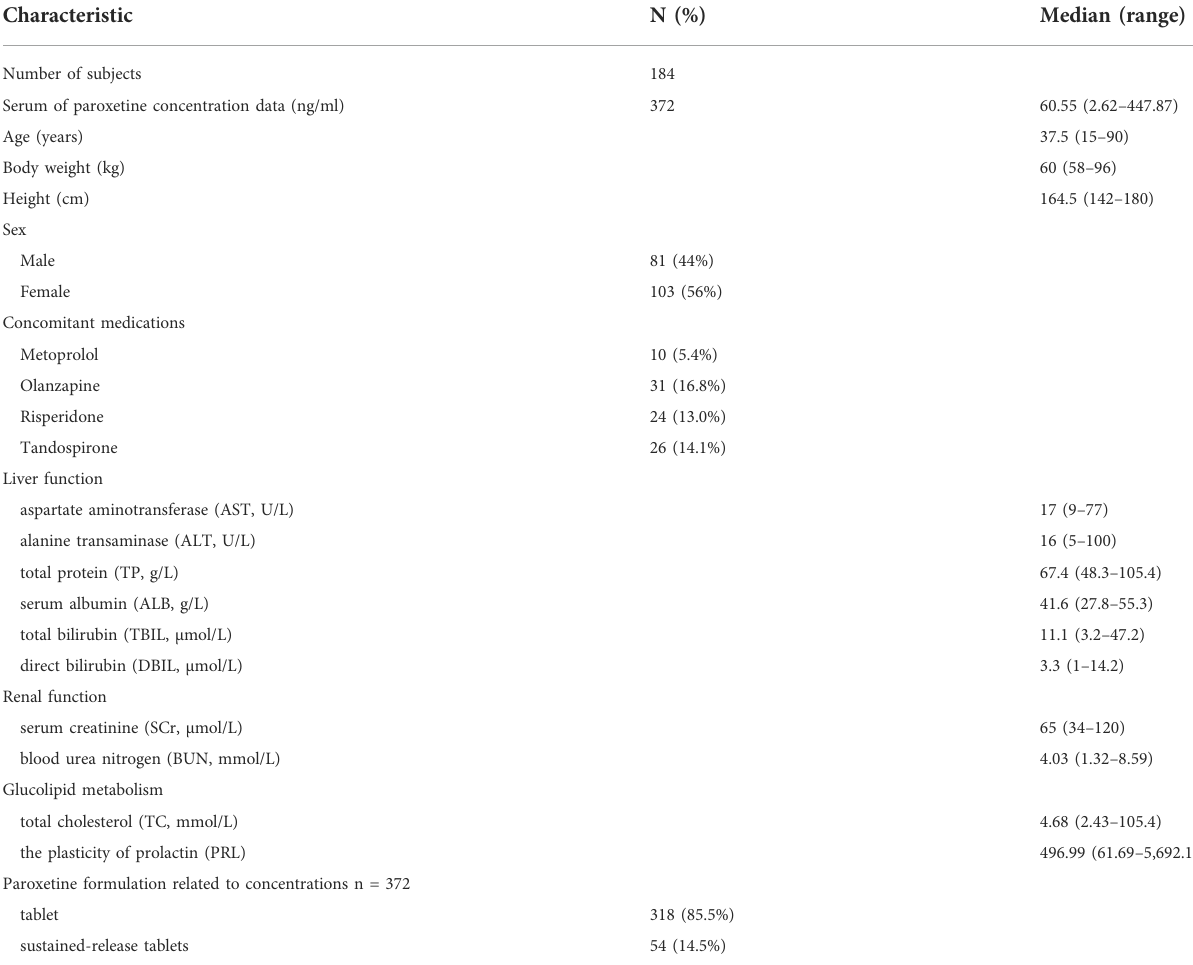
TABLE 1 Demographic characteristics and clinical data in this study ( n =